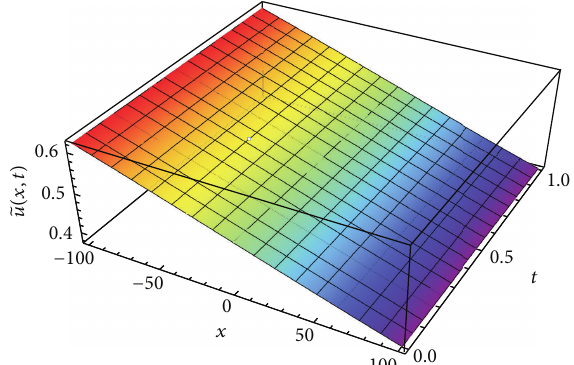
Figure 3: The approximate solution of problem (34) with 𝜃 = 𝜗 = 0 , = 0.01 , 𝜏 = 0.5 , and 𝑁 = 12 𝜆 1